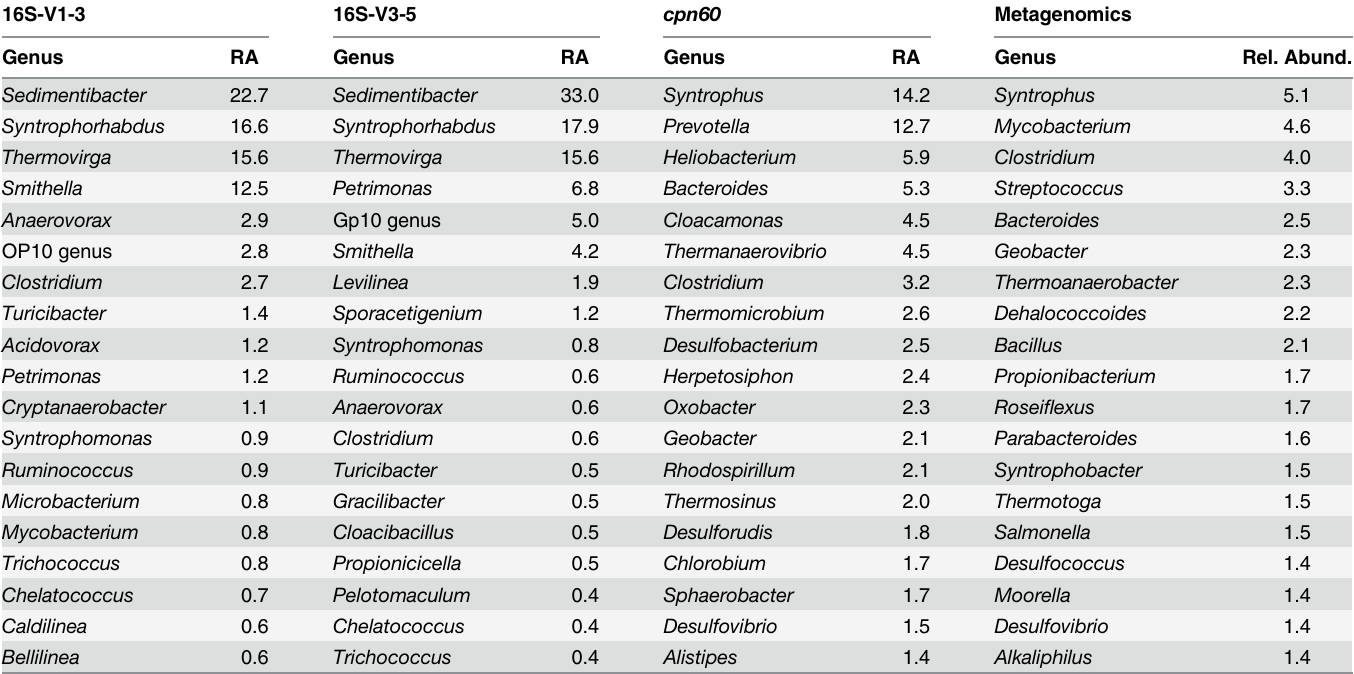
Table 3. Comparison of the 20 most abundant genera determined by different sequencing methods in Plant A biosolids, post-treatment (August 4,